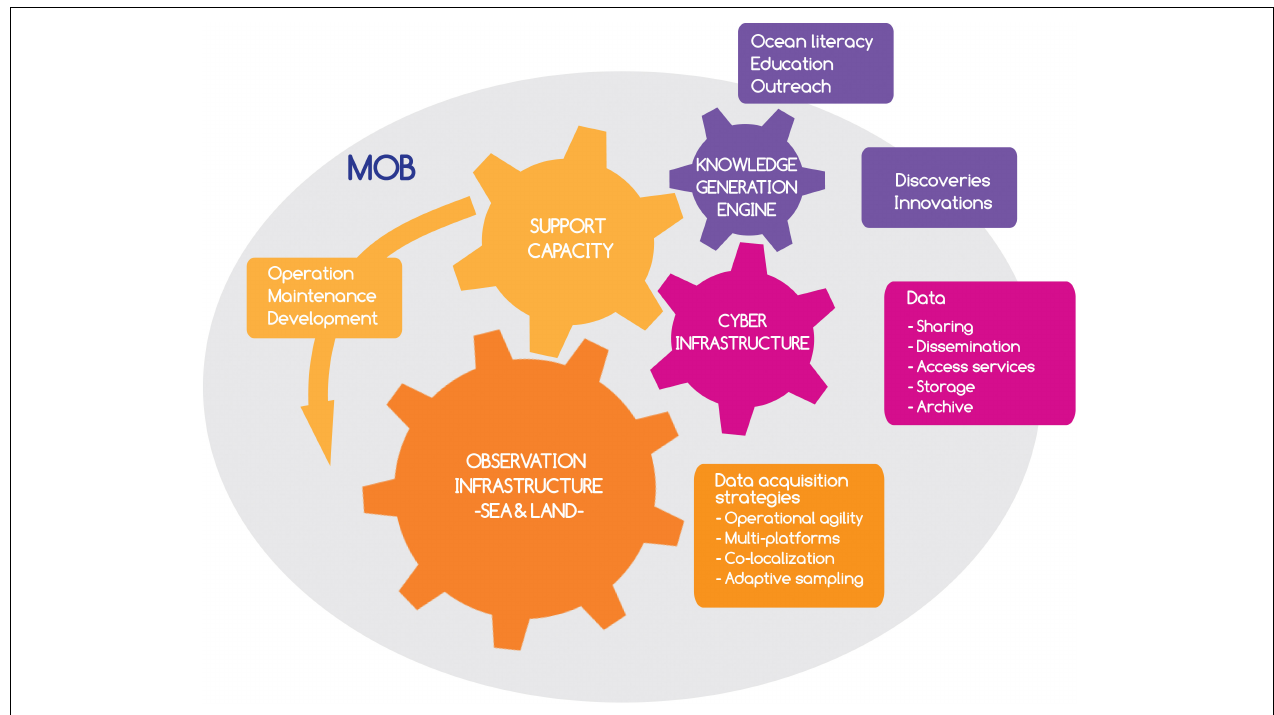
FIGURE 1 | The next generation Marine OBservatory structure (MOB). The oval represents MOB with its four fundamental components: three hard gears (Observation infrastructure, Cyberinfrastructure, and human Support capacity) and one soft gear (Knowledge generation engine). Color-coded boxes represent functionalities and capabilities of the associated